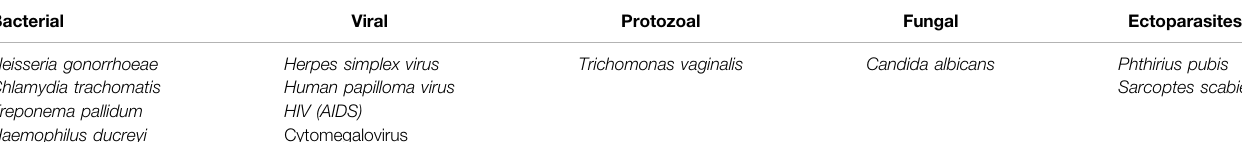
TABLE 1 | Etiological classi fi cation of the most common STDs. Bacterial